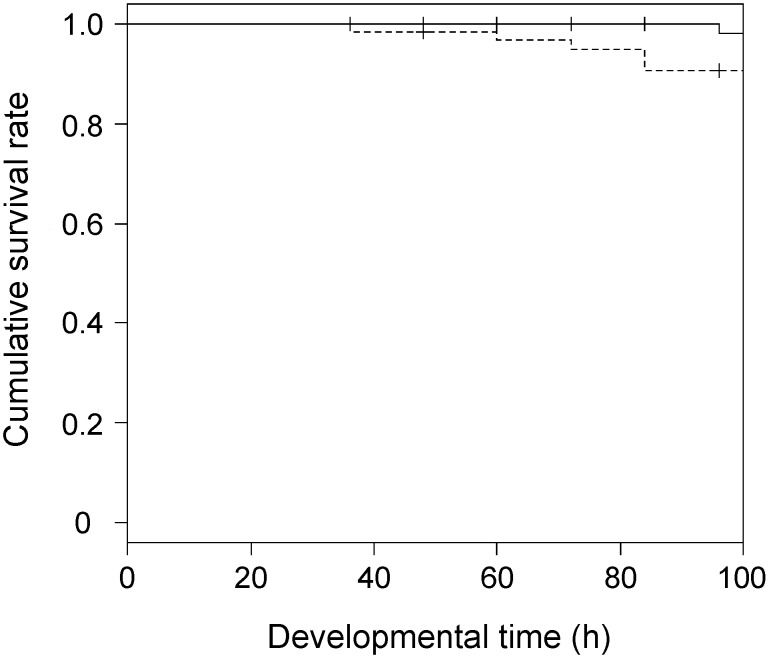
Cumulative survival rate of Thrips palmi larvae (Kaplan-Meier).The virus-free larvae were reared on the bean leaves (n = 65, solid line). The viruliferous (infected with Watermelon silver mottle virus) larvae were reared on the bean leaves (n = 70, dashed line).